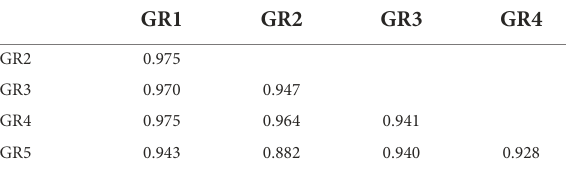
GR corresponds to the time point, from 1 to 5. In all cases, p < 0.01.